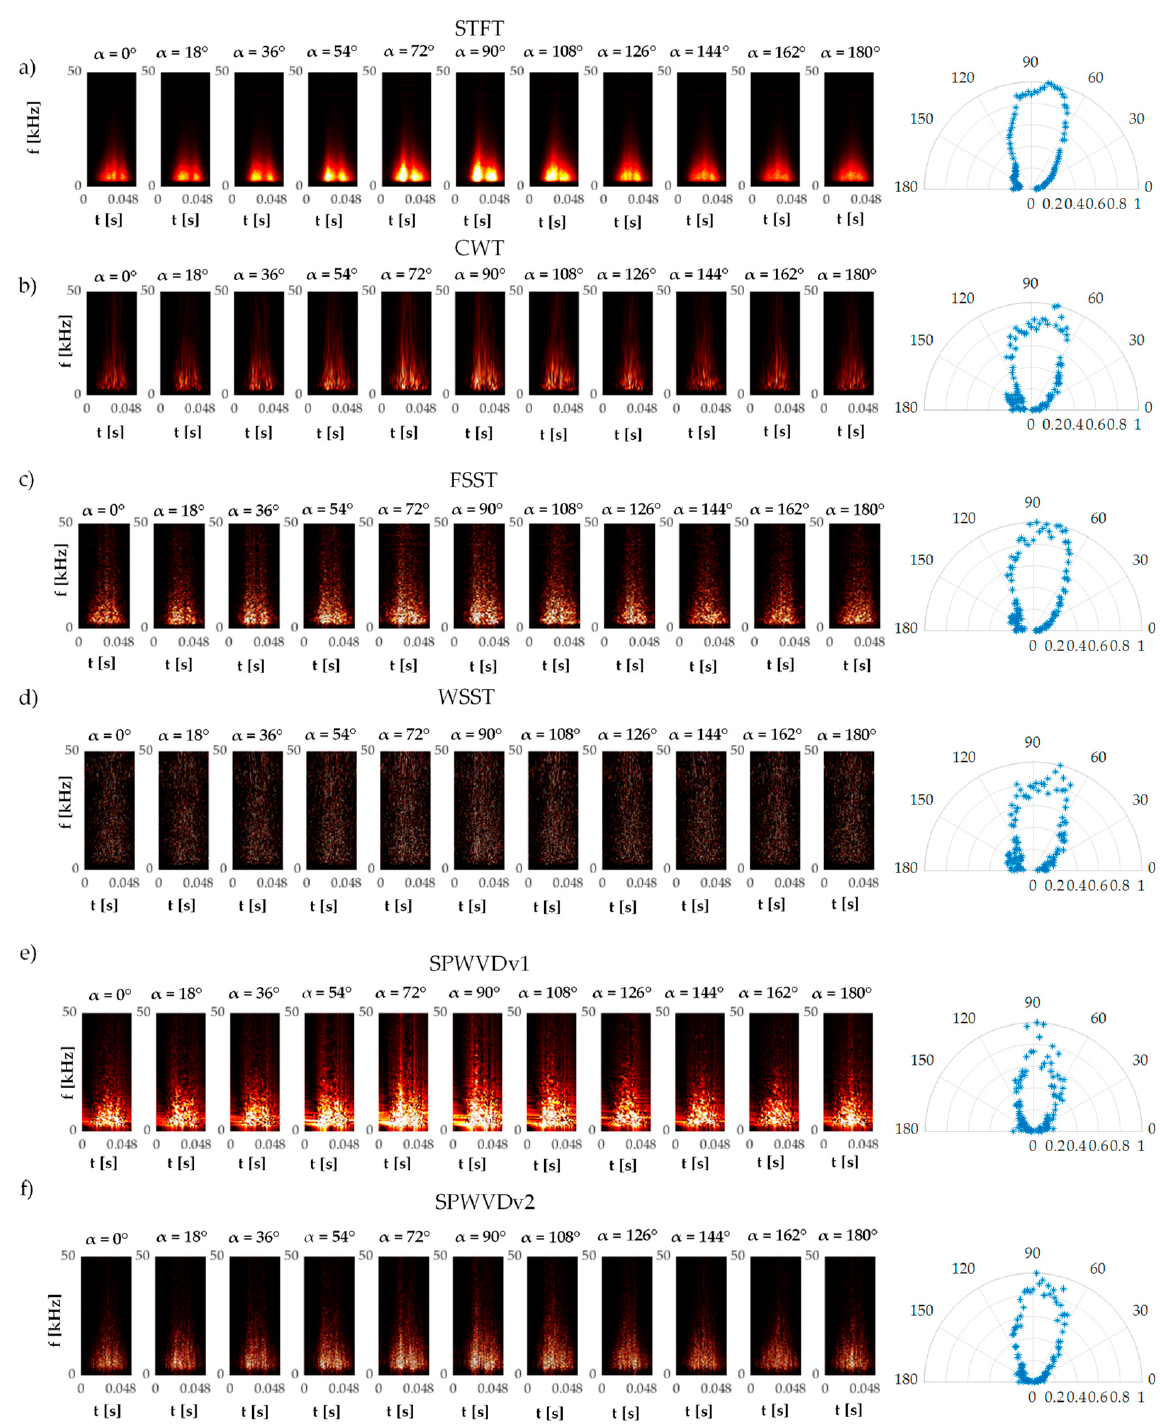
Figure 4. Spectrograms obtained on the basis of considered transformations: ( a ) STFT ( b ) CWT ( c ) FSST ( d ) WSST ( e ) SPWVDv1 ( f ) SPWVDv2 .